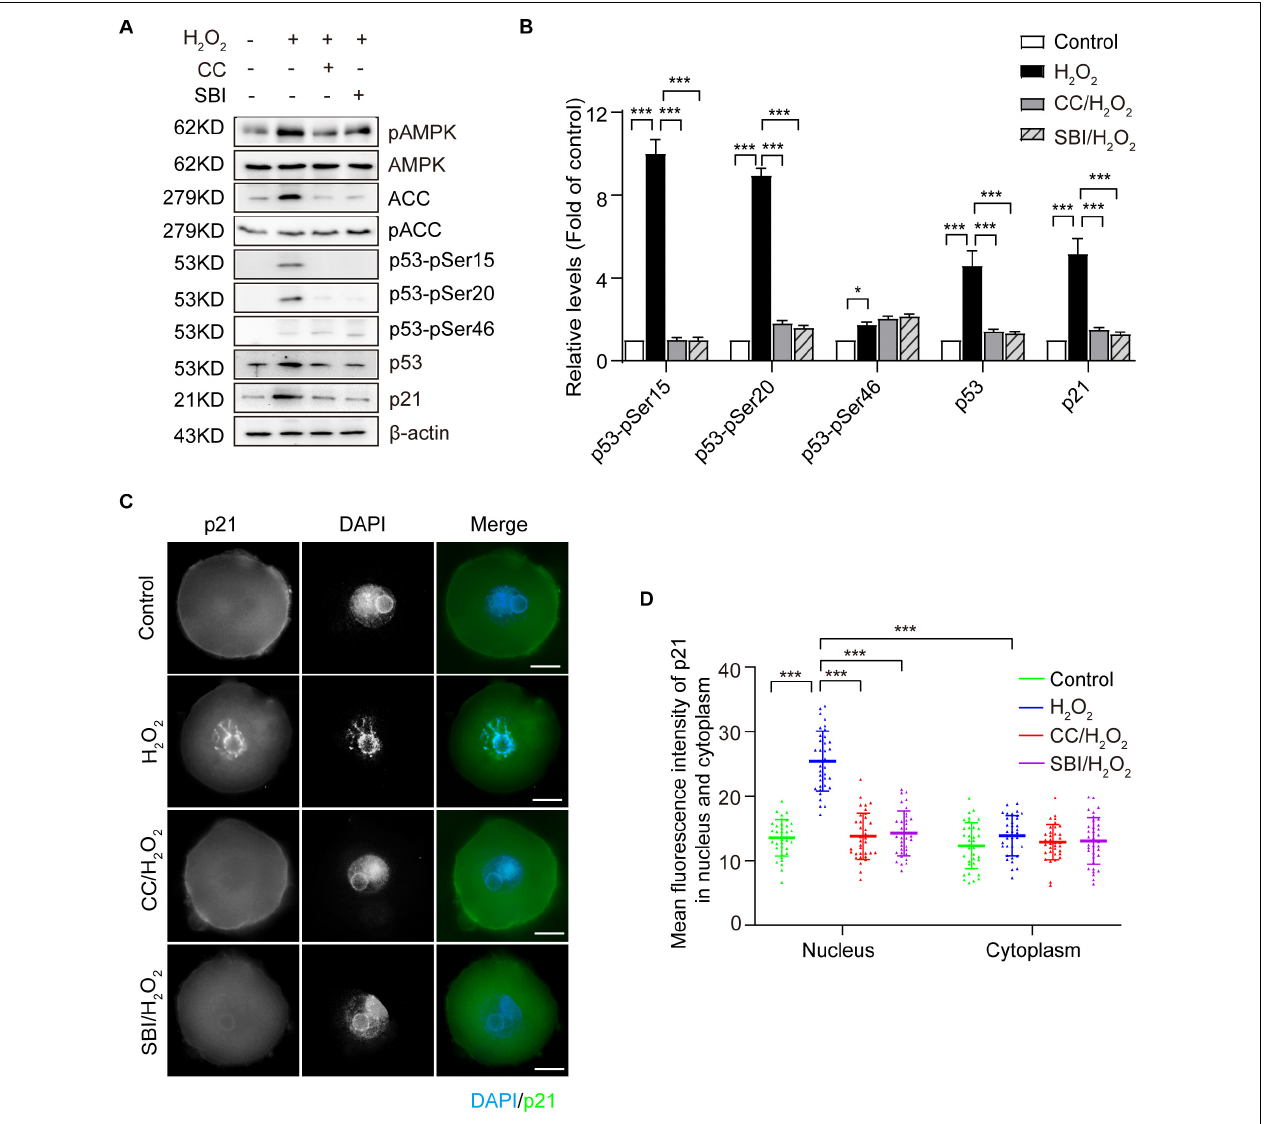
FIGURE 5 | Activated AMPK regulates the oxidative stress induction of cell cycle regulatory proteins of p53 and p21 in mouse zygotes. CC, Compound C; SBI, SBI-0206965. (A) Representative data showing the level of p53, p21, p53-pSer15, p53-pSer20 and p53-pSer46 in control, H 2 O 2 -treated, Compound C/H 2 O 2 -treated, and SBI-0206965/H 2 O 2 -treated zygotes in the G2 phase. (B) Quantification data of figure ( n = 3). (C) Representative image of the subcellular distribution and expression of p21 (green) using immunostaining. Nuclei were stained with DAPI (blue). Scale bar = 20 µ m. (D) Mean fluorescence intensity of nuclear and cytoplasmic p21 in mouse zygotes in the G2 phase. N = 37 zygotes per group. Results in (B , D) were analyzed by one-way ANOVA and Tukey’s test. * p < 0.05; *** p < 0.001. Error bars: